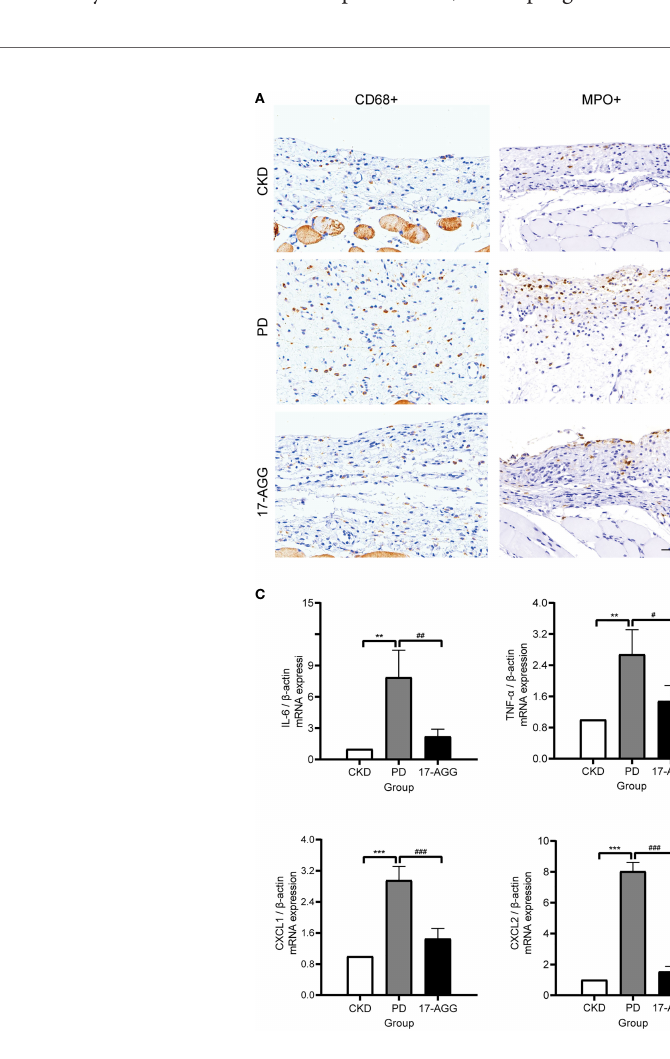
FIGURE 8 | A GP96 inhibitor suppressed the PDF-induced in fl ammatory response in uremic peritoneal dialysis rats. SD rats underwent a subtotal nephrectomy. Four weeks after subtotal nephrectomy, the rat underwent surgery to implant a peritoneal catheter for the acute model of exposure to 4.25% Dianeal or saline (5 mL/100 g body weight, twice a day for 10 days). The PD group was instilled with PDF. For 17-AGG experiments, PDF-instilled rats were treated with 17-AGG (50 mg/kg) every 3 days via the peritoneal catheter, starting 2 h before daily PDF instillation. Daily instillation of PDF caused a marked increase in the in fi ltration of in fl ammatory cells and proin fl ammatory gene expression in the peritoneum, which was reversed by 17-AGG. (A) Immunohistochemical staining of CD68 + or MPO + in the peritoneum sections from CKD, PD and 17-AGG groups, respectively. A representative picture of each group (magni fi cation ×200) is shown. Scale bar: 100 m m. (B) The quanti fi cation of the immunostaining. (C) Real-time PCR of gene expression. All results were presented as mean ± SD from three independent experiments. Statistical analysis was performed with one-way analysis of variance (ANOVA) for three groups. ** p < 0.01 and *** p < 0.001, compared with the CKD group; # p < 0.05, ## p < 0.01 and ### p < 0.001 compared with the PD group; n = 5 per